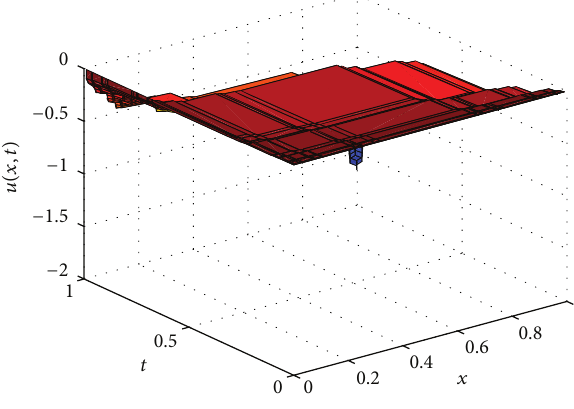
Figure 1: The solution of (1) with initial-boundary value (25) when 𝑎 = 1 and 𝛼 = ln 2/ ln 3